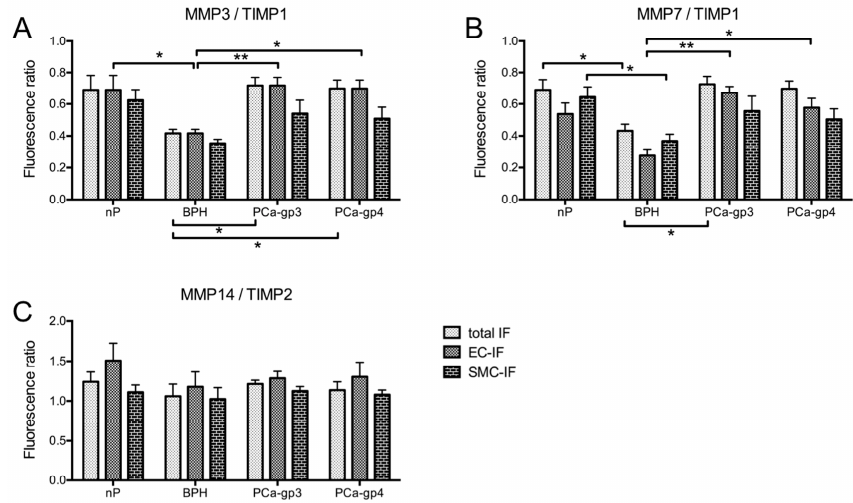
Figure 5. Cellular distribution of MMP/TIMP ratios. Ratios (mean (SEM)) were calculated from means of FI target /FI bkgrd of the respective MMP-TIMP pairs and presented as FI-ratio. Note that MMP14/TIMP2 ratios are >1.0 indicating excess of MMP14 ( C ), while MMP3/TIMP1 and MMP7/TIMP1 ratios are <1.0 indicating excess of TIMP1 ( A , B ). Kruskal–Wallis test with post-hoc Dunn’s Multiple Comparison test as indicated by bars (* p < 0.05; ** p < 0.01); no significant differences were observed between EC and SMC.